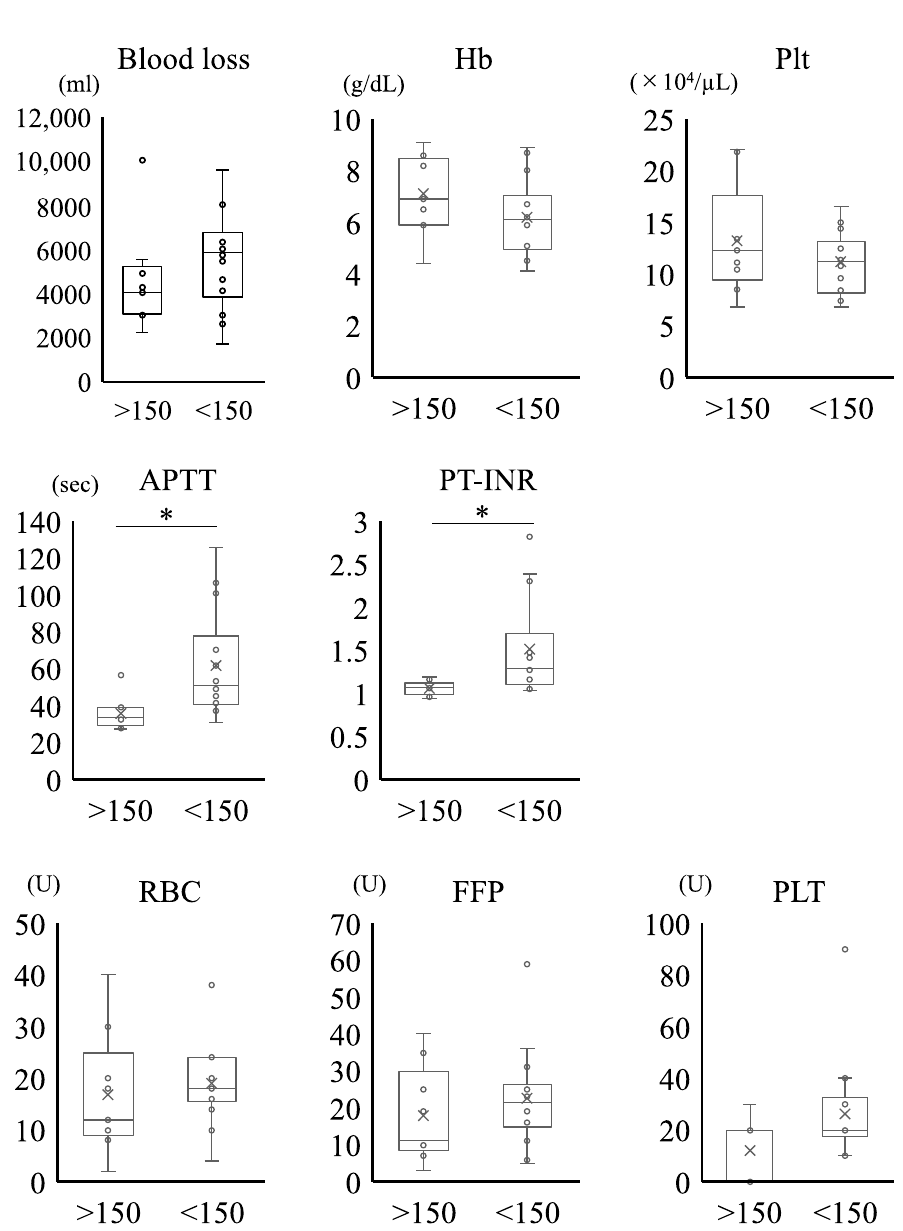
Figure 4. Comparison of clinical and laboratory parameters between ≥ or <150 mg/dL fibrinogen (FNG) groups. Hb, hemoglobin concentration (normal range, 11.6–14.8 g/dL); Plt, platelet count (normal range, 15.8–34.8 104/ μ L); FNG, fibrinogen (normal range, 150–400 mg/dL); APTT, activated partial thromboplastin time (normal range, 24–39 s); PT-INR, International Normalized Ratio of Prothrombin Time (normal range, 0.90–1.10). The amount of RBC, FFP, and PLT transfusions is described by Japanese units, which is defined as that derived from 200 mL whole blood. *: p <0.05